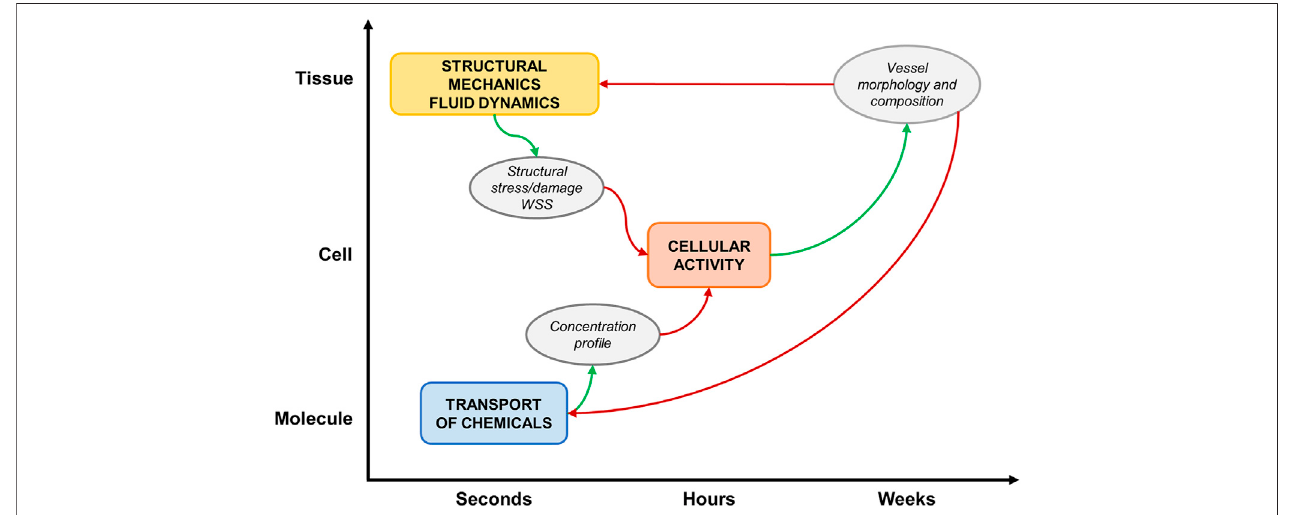
FIGURE 4 | Schematic representation of a general multiscale framework of vascular adaptation. The main simulated events at the different spatio-temporal scales are: 1) structural mechanics and fl uid dynamics, 2) cellular activity and 3) molecular transport. The modules receive proper inputs (red arrows) and generate suitable outputs (green